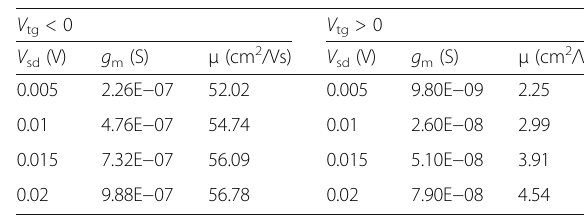
Table 2 The mobility of SnSe 2 FET with top gating measured under